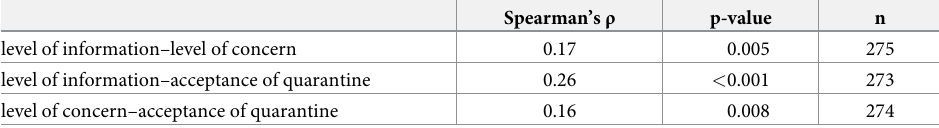
Table 1. Correlation between level of information, level of concern and acceptance of